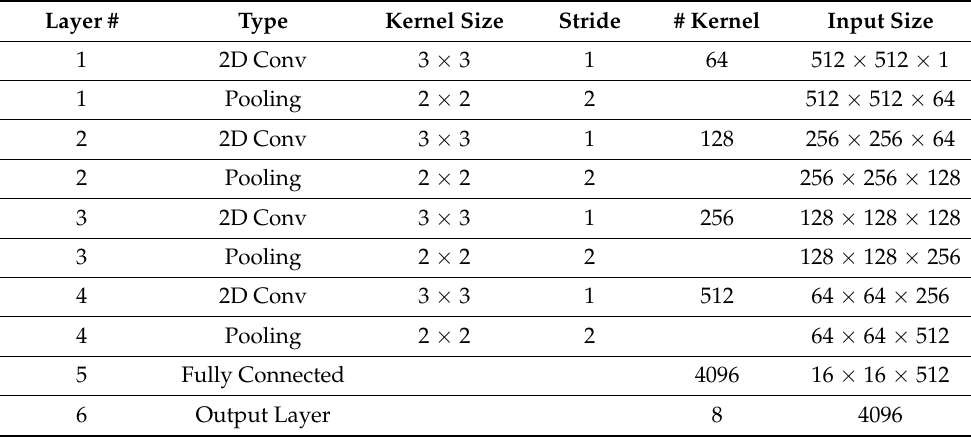
Figure 5. The proposed architecture of 2D CNN model. Table 2. The architecture of the proposed 2D CNN